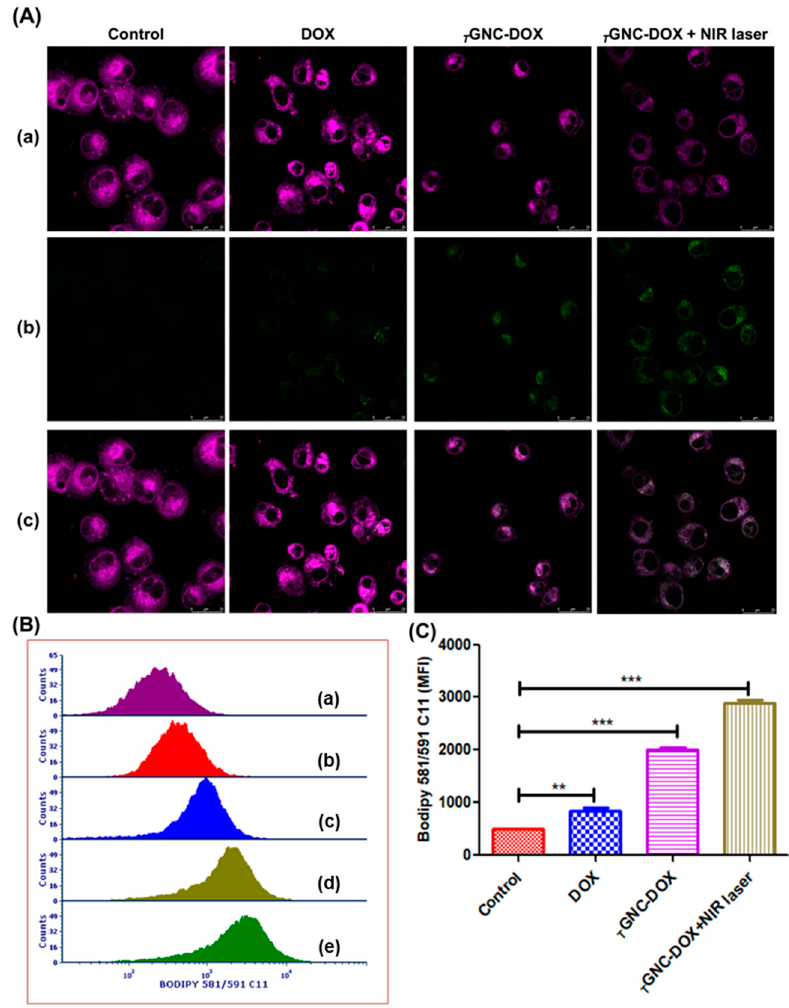
Figure 15. Lipid peroxidation level followed by treatment of: ( A ) CSLM images of different groups with ( a ) non-oxidized BODIPY C11 dye, ( b ) oxidized BODIPY C11 dye, ( c ) merged images. ( B ) Representative flow cytometry analysis fluorescent intensity images of different groups ( a ) unstained ( b ) control ( c ) DOX, ( d ) T GNC-DOX only, ( e ) T GNC-DOX + NIR laser. ( C ) Bar graph showing relative percentage mean fluorescence intensity of BODIPY C11 dye followed by different treatments ( n = 3) (*** p < 0.001, ** p < 0.01) (scale: 25 µ